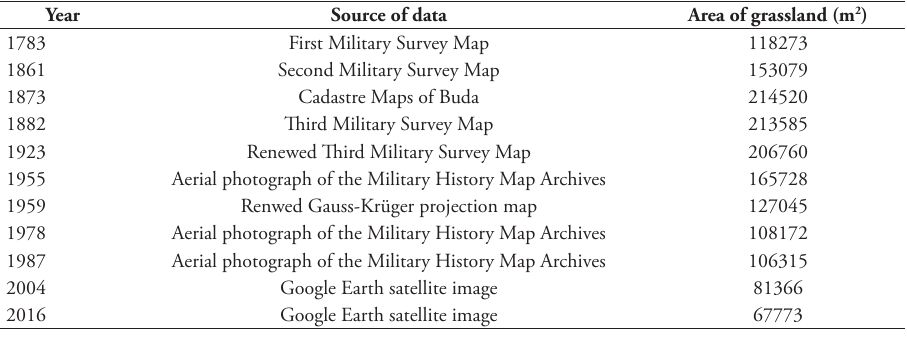
Table 2. Extension of grasslands on the Széchenyi Hill (1783–2016).